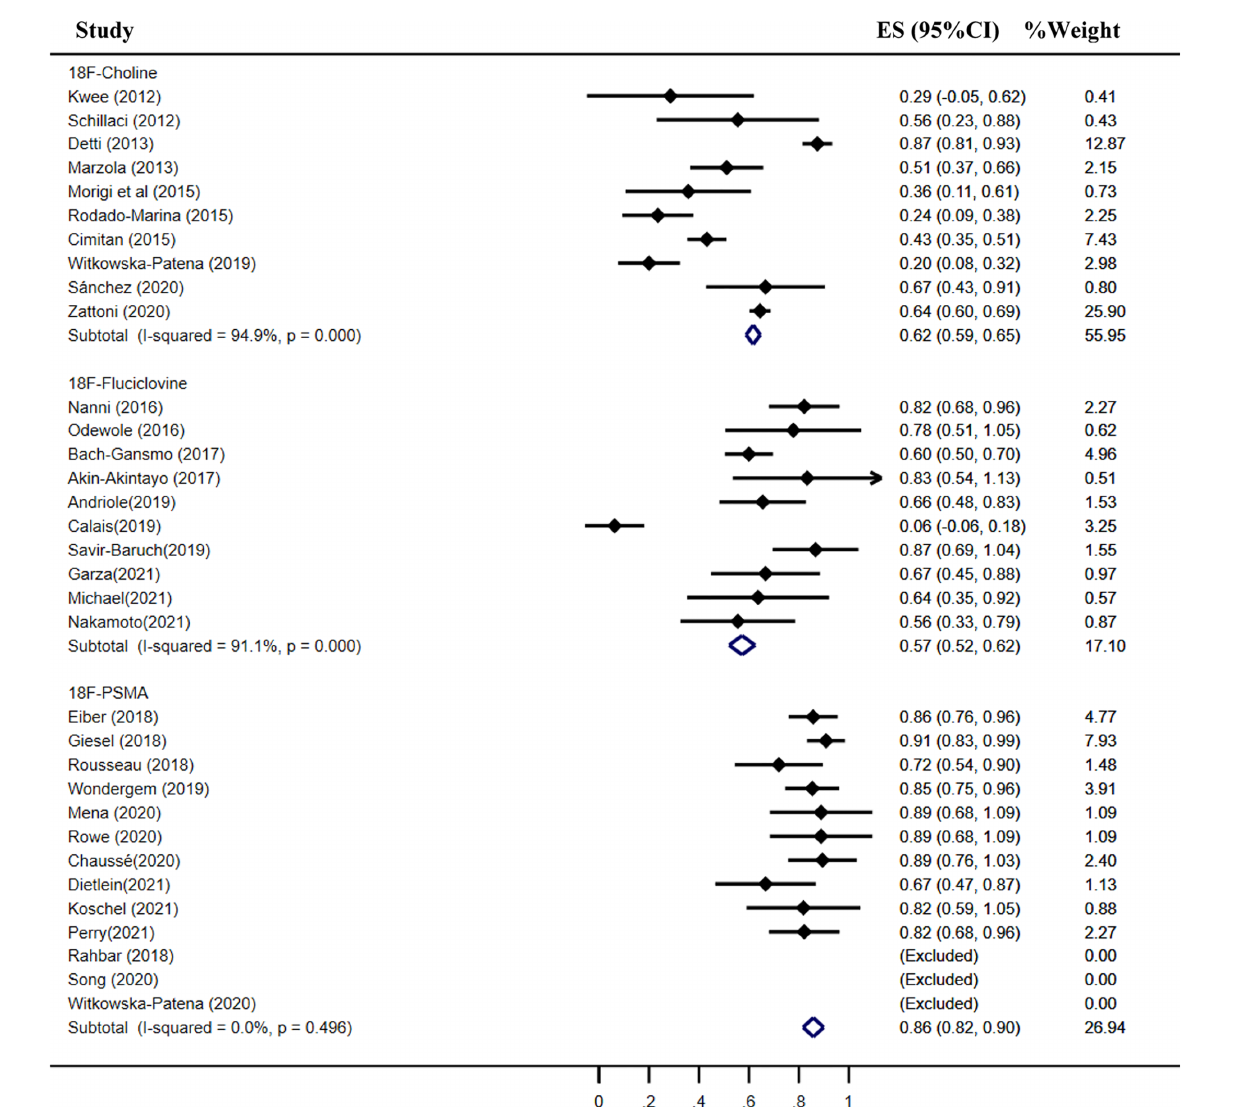
FIGURE 9 | Forest plot of the proportion of 18 F-labeled choline, fl uciclovine, and PSMA positivity of prostate cancer patients with BCR for PSA 1.0 – 1.99